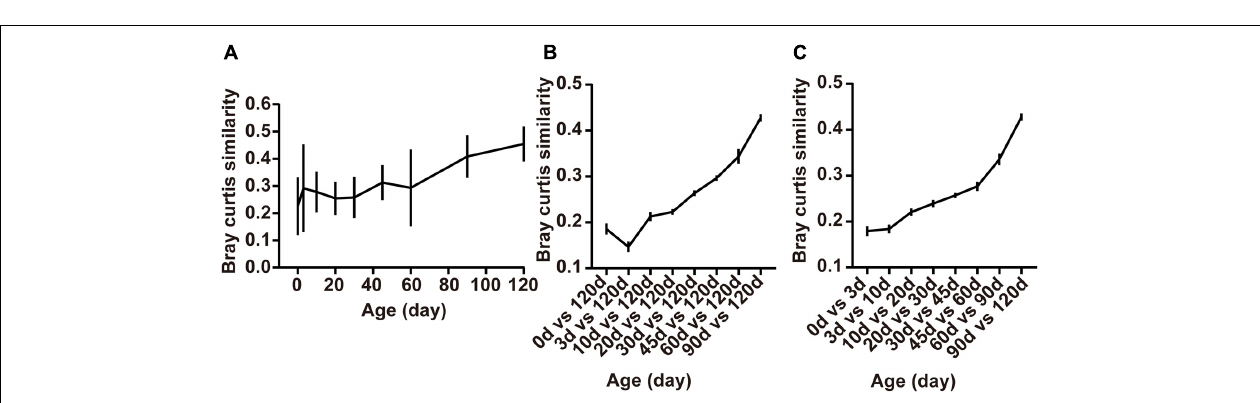
FIGURE 3 | Effect of the age of lambs on rumen bacterial communities. (A) Species richness estimates (Chao1 index) and (B) diversity (Shannon index) for the nine sampling time points. (C) Scatterplot from non-metric multidimensional scaling (NMSD) of bacterial Bray-Curtis distance in each sample. (D) Relative abundance of bacterial phyla at different ages of the lambs. a , b Letters denote significant differences between groups; groups that do not share the same letter are significantly different from each other ( P < 0.05).